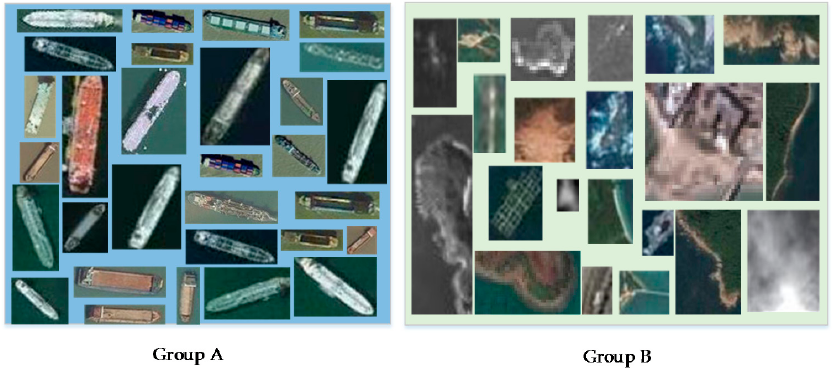
Figure 10. Examples of the extracted ship candidates. Group A corresponds to the ship targets while group B consists of false alarms.